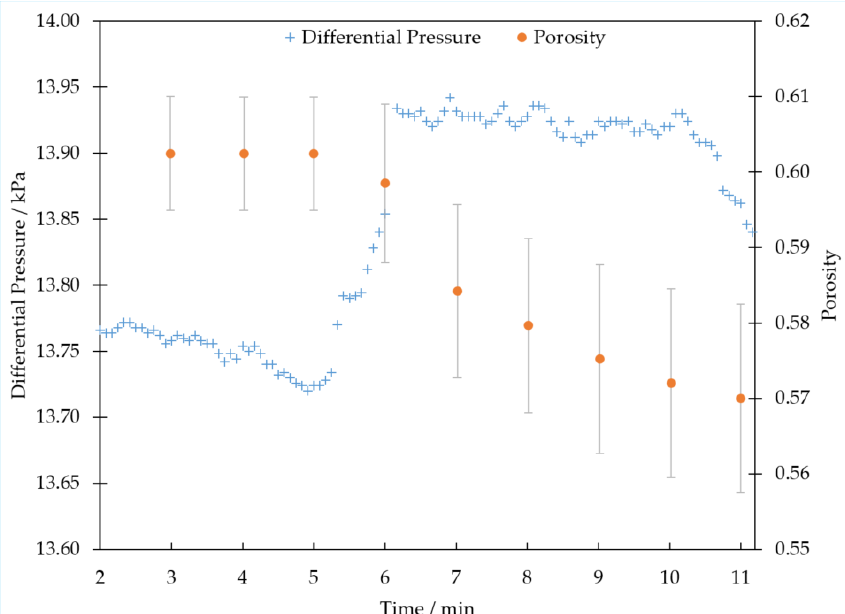
Figure 7. Plot of porosity and the pressure difference between the filter sample inlet and outlet against time during an in-situ filtration. Each porosity data plot represents the point in the time series where a tomography scan was finished ( ∼ 1 per minute), each porosity value is calculated from a representative volume as discussed above. Porosity error bars are calculated as described in Section 2.4 and the differential manometer has a resolution of 0.01